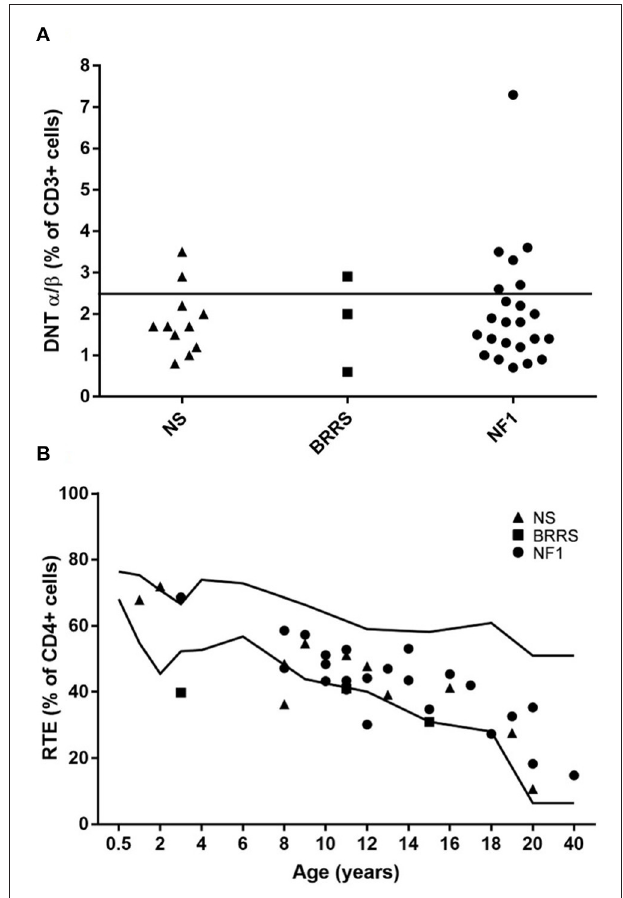
FIGURE 3 | (A) Double negative T (DNT) α / β + cells expressed as percentage of lymphocytes T (CD3 + cells) grouped according to the three syndromes evaluated in our cohort. (B) Recent thymic emigrants (RTE) expressed as percentage of lymphocytes T helper (CD4 + cells) displayed according to age. NS, Noonan syndrome; BRRS, Bannayan-Riley-Ruvalcaba syndrome; NF1, Neurofibromatosis type